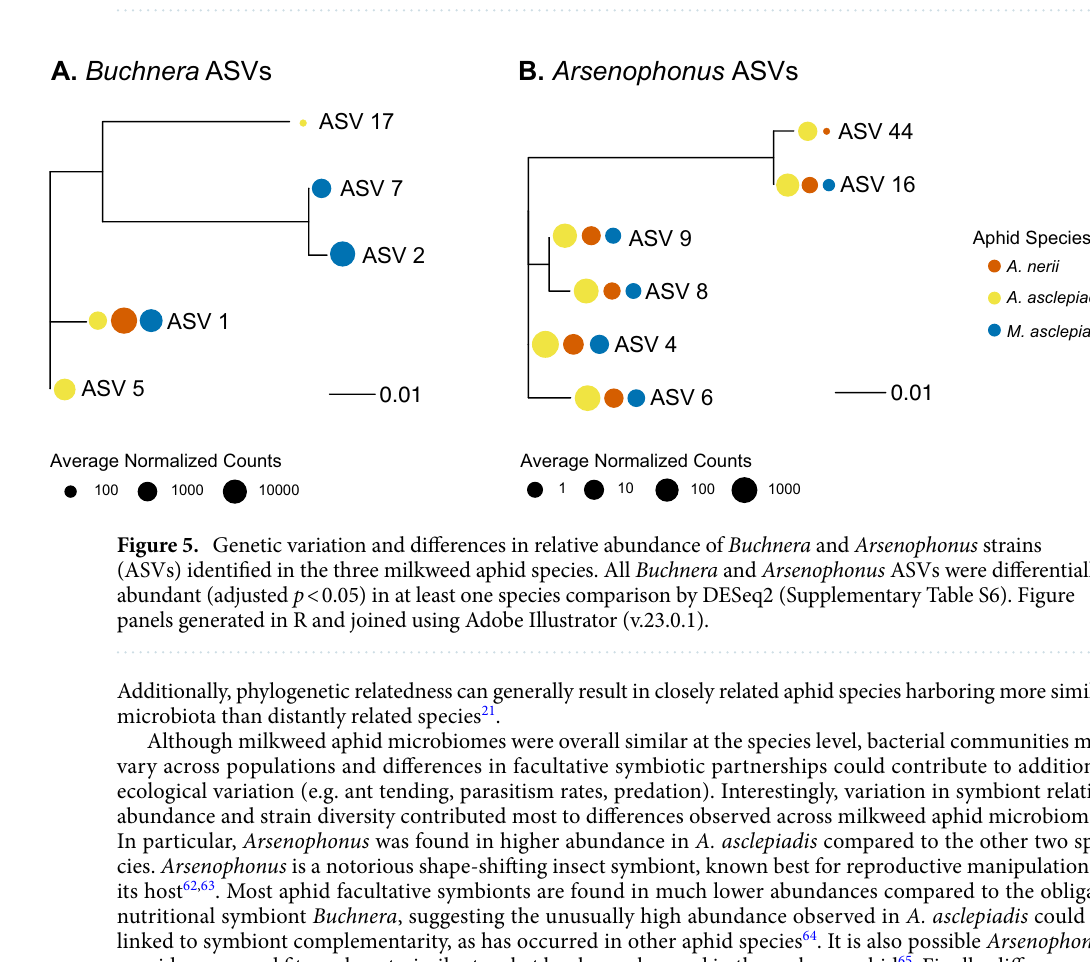
Figure 4. Species richness and evenness within aphid bacterial communities were compared across aphid species. Differing letters indicate significant differences at p < 0.05 by Wilcoxon Rank Sum Test (Supplementary Table S5).